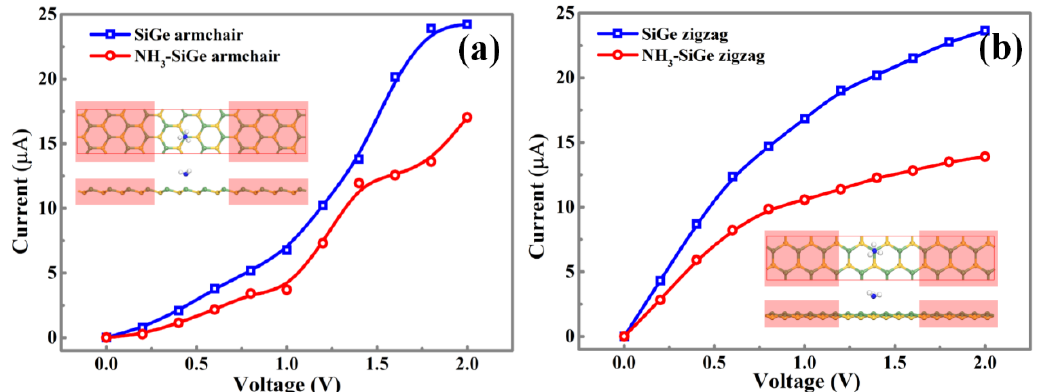
Figure 11. The I-V curves along the two directions of the pure SiGe monolayer and SiGe with the NH 3 - Ge adsorption. The armchair direction ( a ) and zigzag direction ( b ) are shown above.